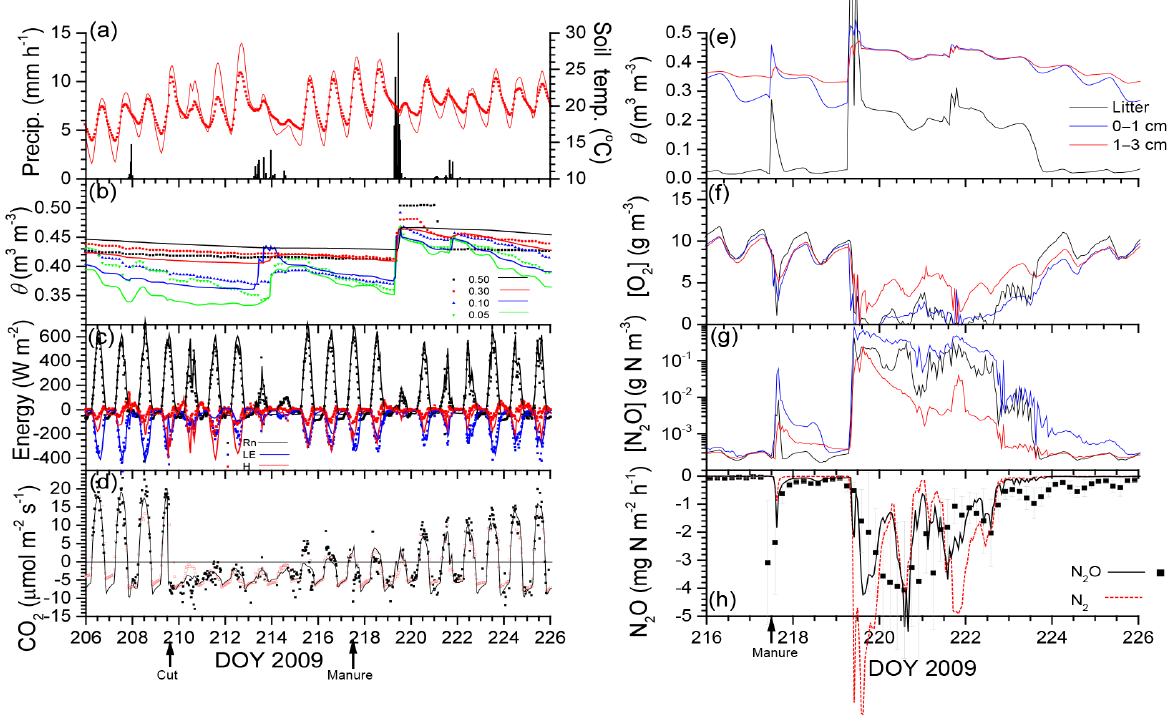
Figure 5. (a) Precipitation and soil temperature at 0.05m, (b) soil water content ( θ ) at 0.05, 0.10, 0.30 and 0.50m, (c) energy, and (d) CO 2 fluxes measured (closed symbols), gap-filled (open symbols) and modelled (lines) during 20 days from harvest (cut) to the end of the emission event following manure application (manure) in August 2008. (e) θ , (f, g) aqueous concentrations of O 2 and N 2 O modelled in the surface litter and at 0.01 and 0.02m in the soil, and (h) N 2 O and N 2 fluxes measured (symbols) and modelled (lines) during the last 10 days of this period when the emission event occurred. Positive flux values represent influxes to the soil, negative values effluxes to the atmosphere.